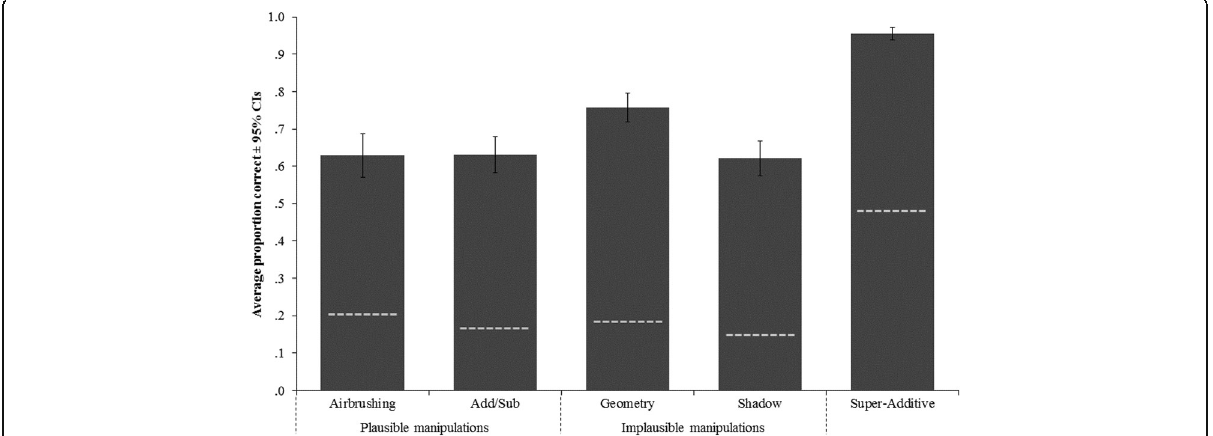
Fig. 4 Mean proportion of correct “ locate ” decisions when subjects correctly detected that the photo was manipulated (i.e., correctly said “ Yes ” on the detection task). The grey dotted lines on the bars represent chance performance for each manipulation type. Error bars represent 95%